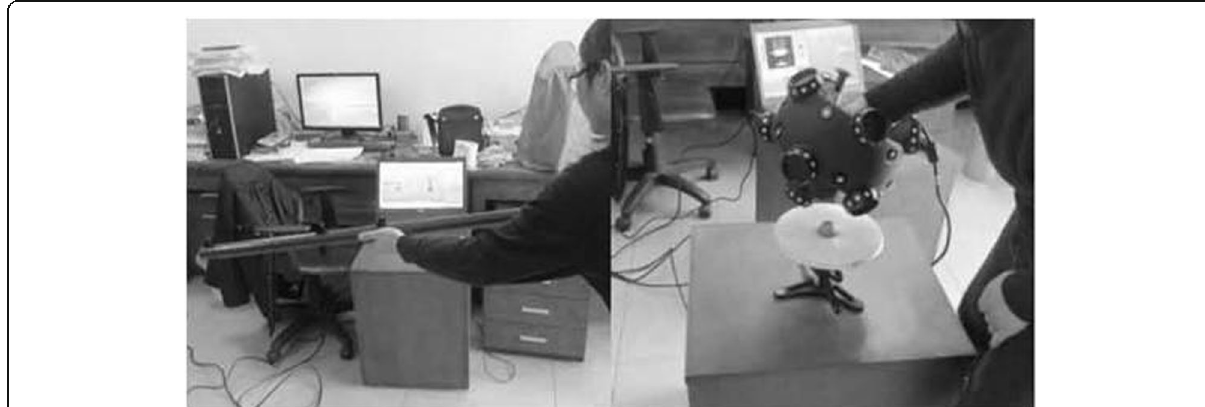
Fig. 5 C-Track 780 dual-camera sensor